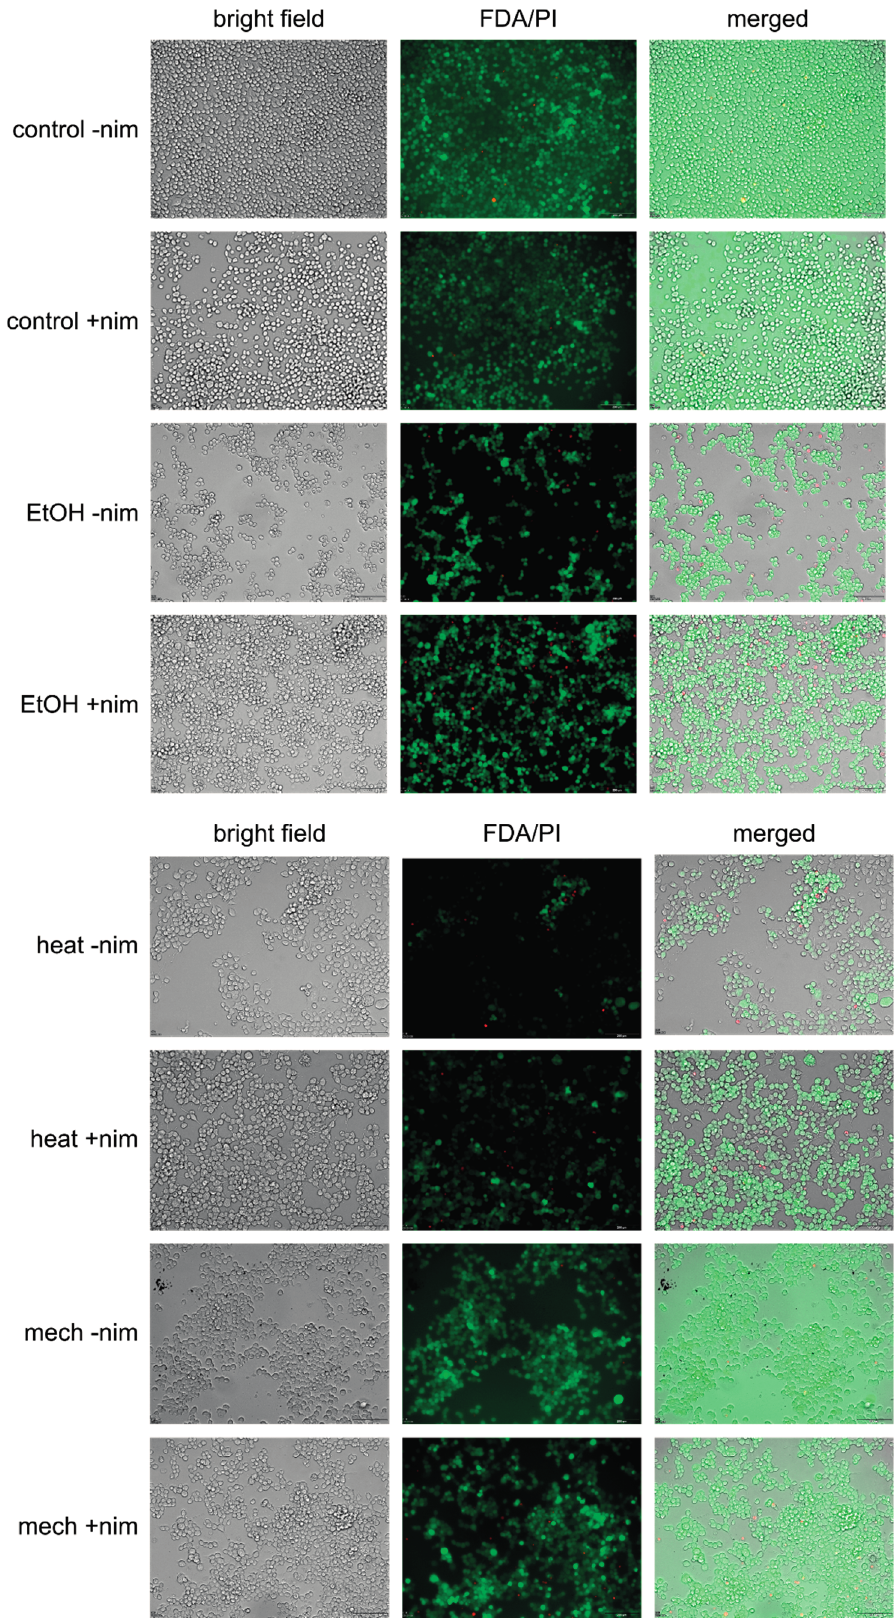
Figure 5. Live/dead staining with fluorescein diacetate (FDA) and propidium iodide (PI). –nim = w/o nimodipine; +nim = 20 µM nimodipine; EtOH = 2% ethanol; heat = 6 h, 42 °C; mech = shaking with steel beads; scale bar = 200